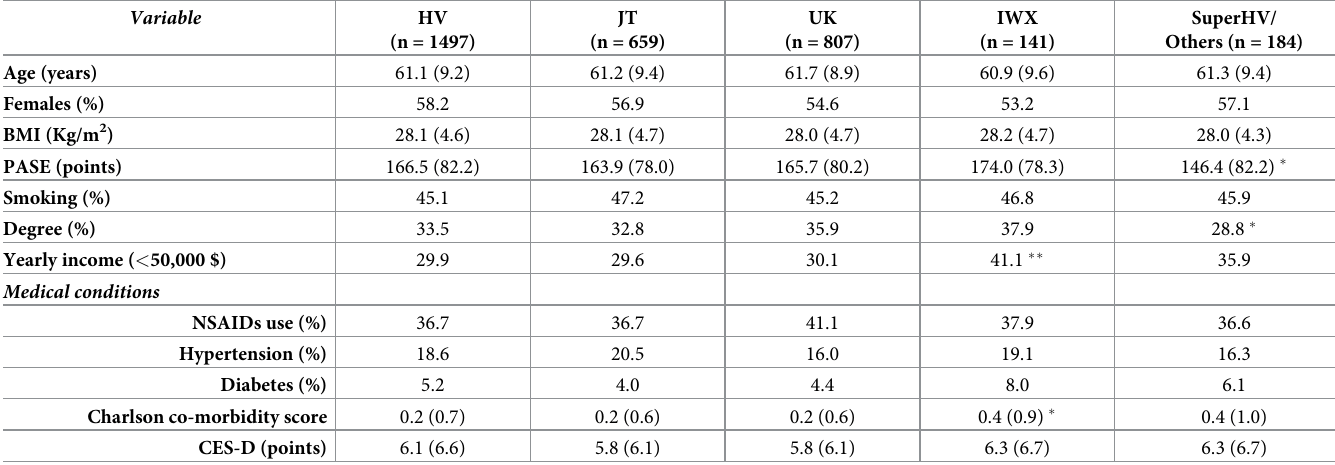
Table 1. Baseline characteristics by mitochondrial